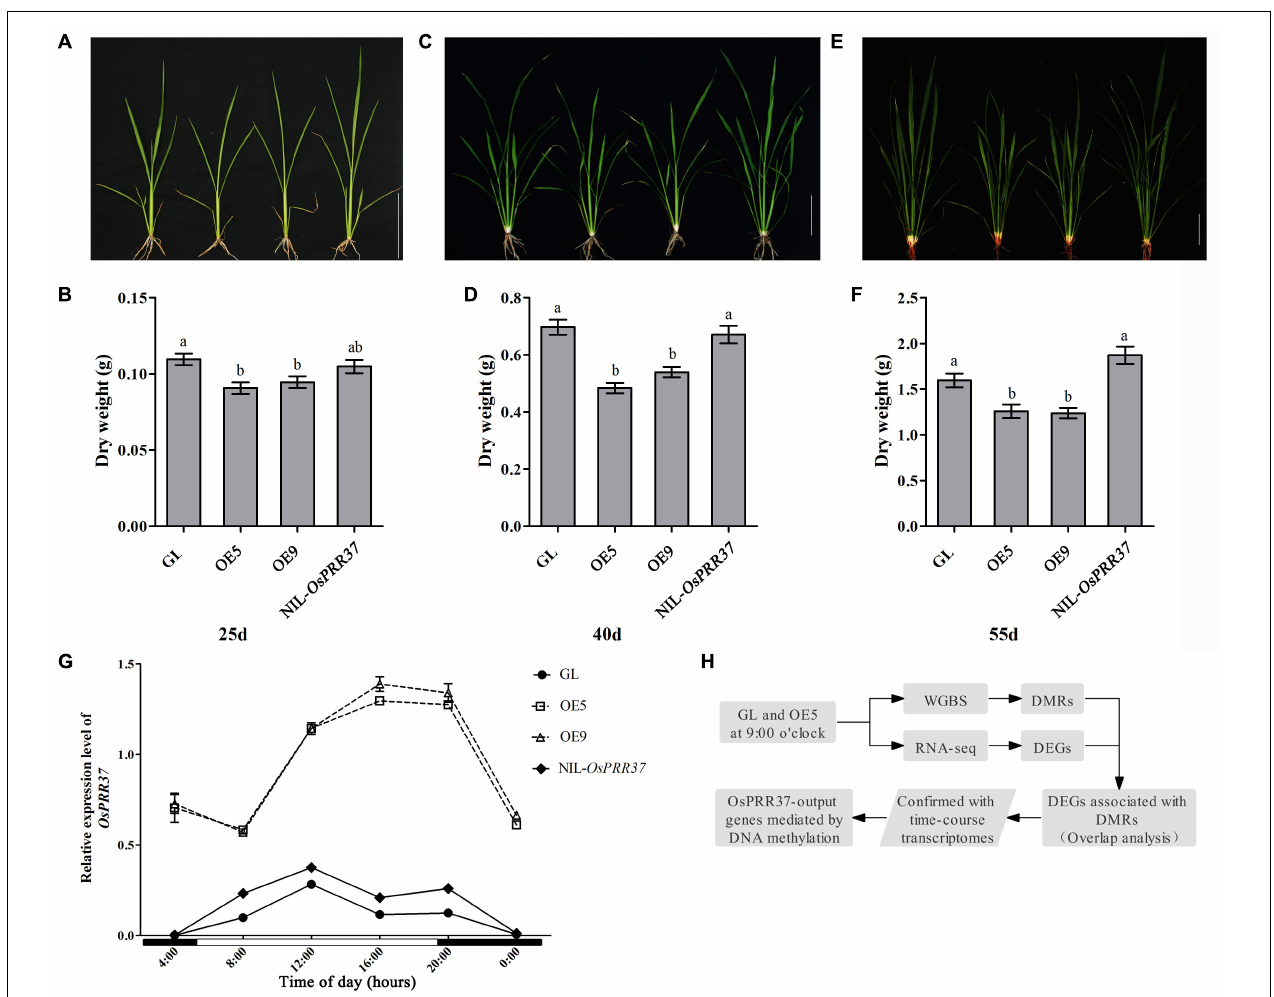
FIGURE 1 | Characterization of rice growth and OsPRR37 expression rhythms. Rice growth morphology and dry weight were documented at 25 days (A,B) , 40 days (C,D) , and 55 days (E,F) after sowing the seeds. The different lower-case characters above bars represent the significant difference level of P < 0.05. (G) The expression levels of OsPRR37 detected by quantitative RT-PCR. The exact time of a natural long-day condition was indicated under the X axis. (H) Simplified workflow of the present study. OE5 and OE9 are two independent transgenic